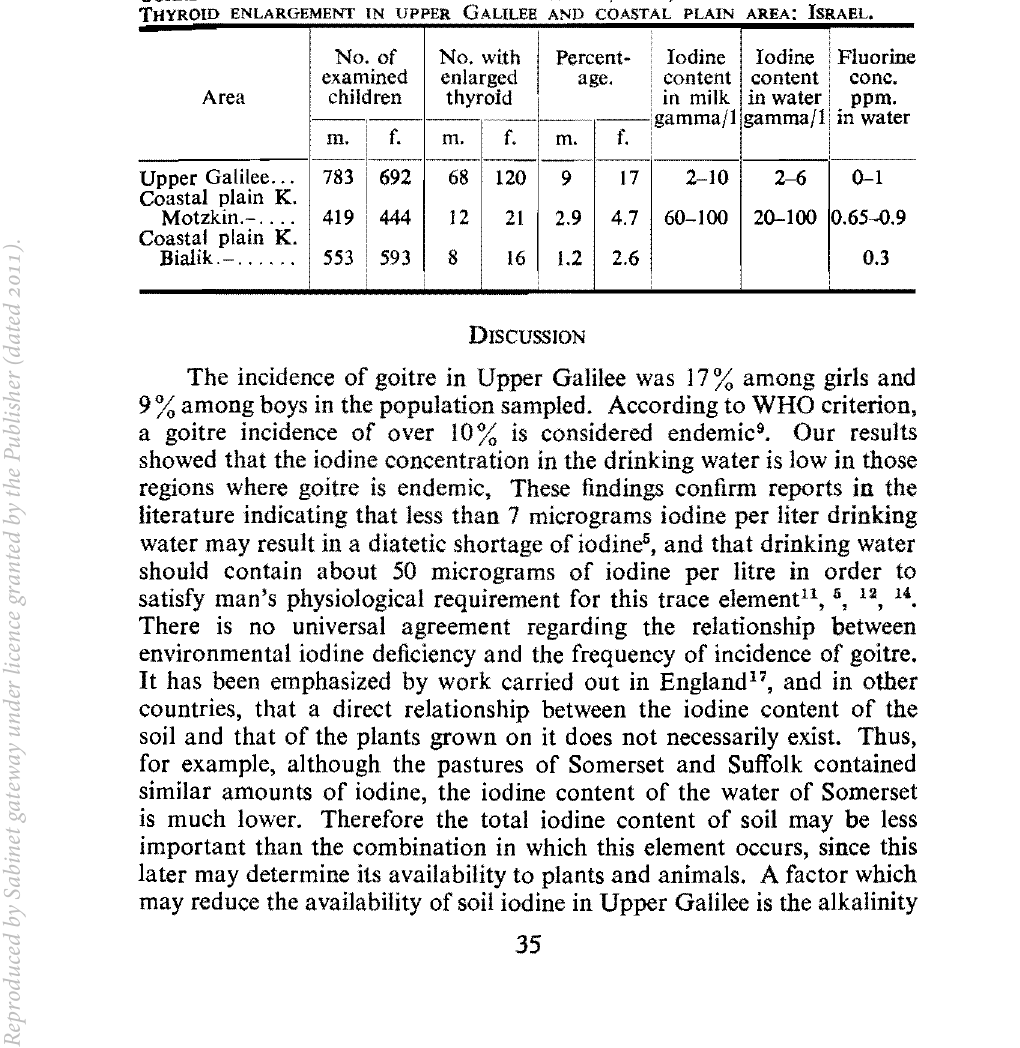
TABLE I. CoRRELATION BETWEEN IODINE CONTENT IN WATER, MILK. FLUORINE IN WATER AND THYROID ENLARGEMENT IN UPPER GALILEE AND COASTAL PLAIN AREA' ISRAEL No.